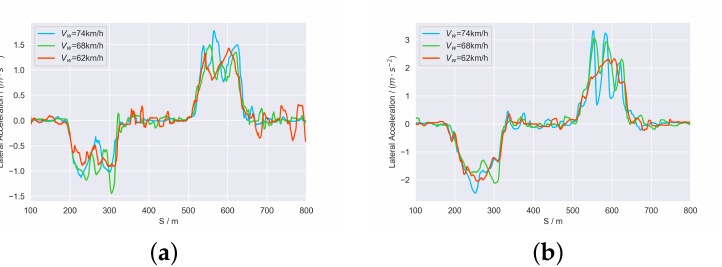
Figure 18. Lateral acceleration of the truck at driving speeds of ( a ) 30 km/h and ( b ) 40